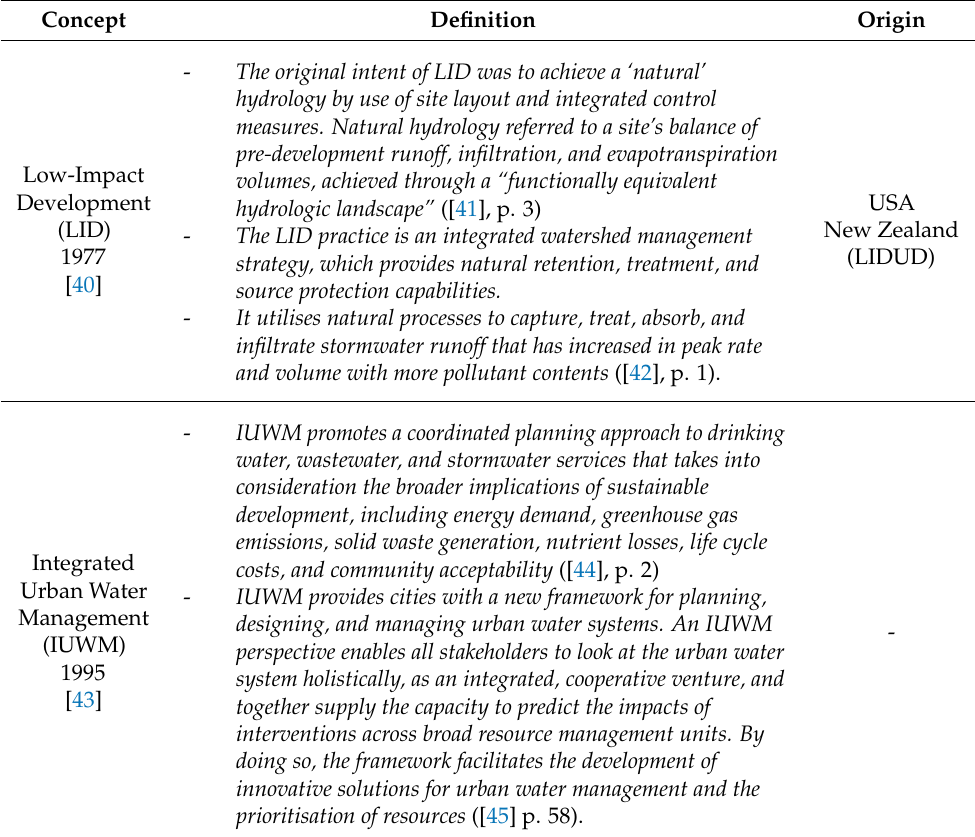
Table 2. Key sustainability concepts associated with water management and the new paradigms in the 21st